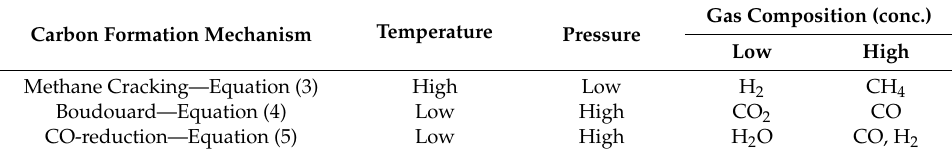
Table 1. Promoting conditions for different routes of carbon